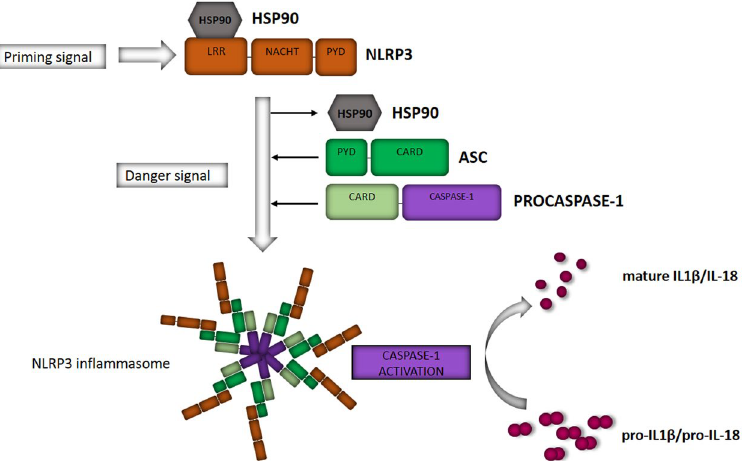
Figure 1. Activation of the NLRP3 inflammasome as a two-step process. After a priming signal NLRP3 protein is synthesized and protected from degradation by a protein complex containing Hsp90. After a second signal, NLRP3 is released from its chaperone, oligomerizes and recruits the receptor protein ASC and pro-Caspase-1 to form the NLRP3 inflammasome. Auto-activation of caspase-1 subsequently leads to the cleavage of pro-IL-1 β and pro-IL-18 into their active